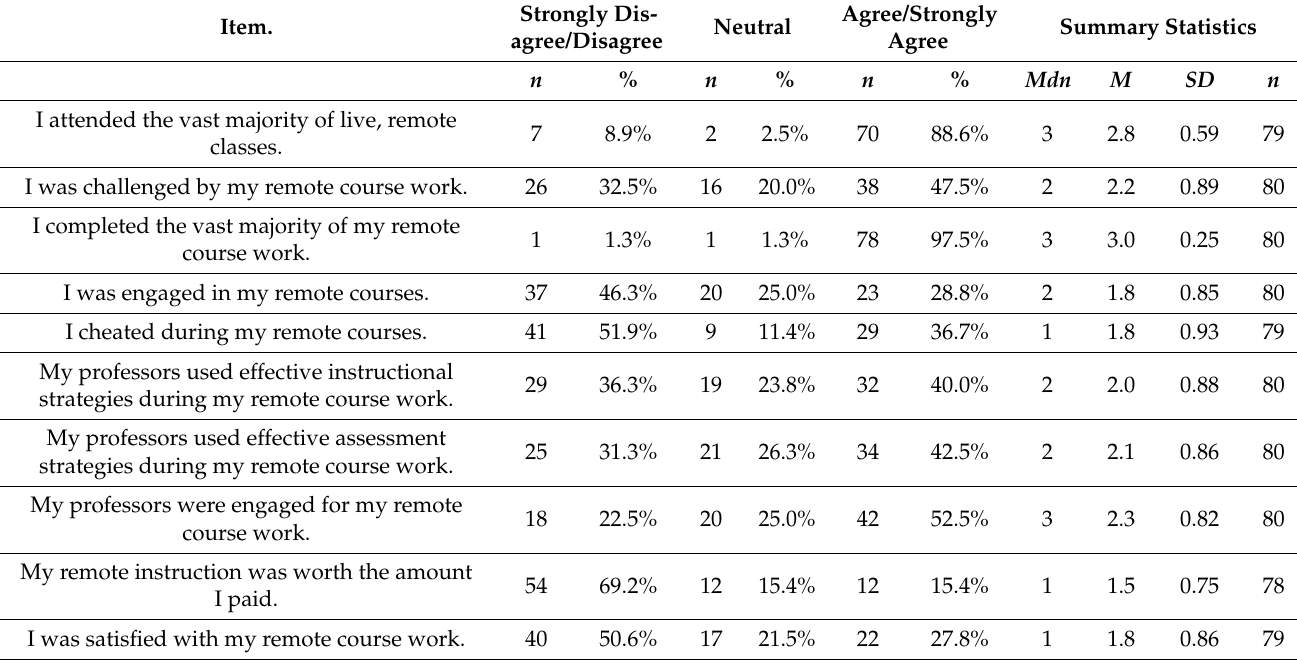
Table 3. General Perceptions of Learning: